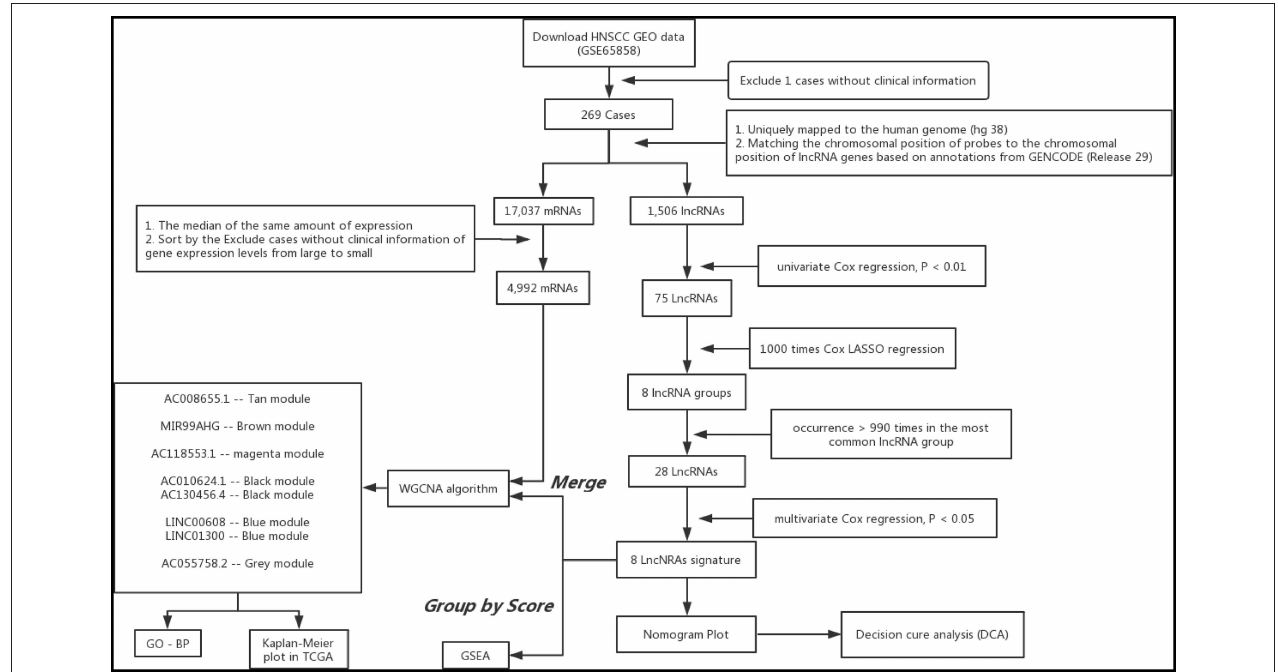
FIGURE 1 | Analysis of flowchart illustrates the exploration procedure for the HNSC prognostic lncRNAs and the related